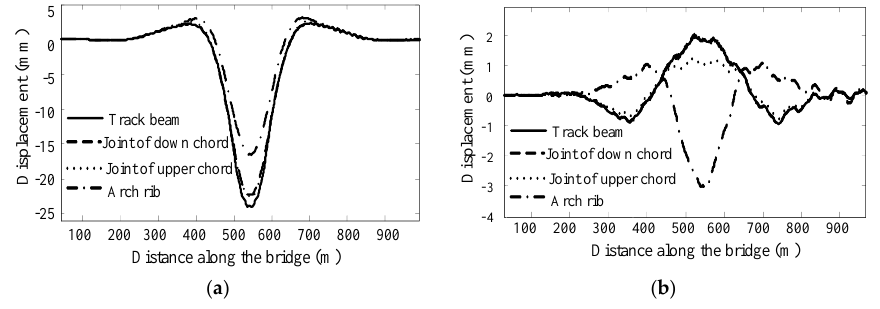
Figure 7a,b plot the simulation results of the time-displacement curves of the track beam, joint of the down chord, joint of the upper chord, and the arch rib in the vertical and transverse direction of the bridge, respectively, under one train running through the bridge at a speed of 60 km/h. The horizontal axis represents the distance along the bridge, which is measured from one end of the bridge. Both the vertical and transverse displacements reach their maximum values when the train arrives at a distance of 530 m on the bridge. Figure 7a shows that the vertical deflection of the track beam is the largest, followed by the deflection of the joint of the down and upper chords. Figure 7b shows that the transverse displacement of the arch rib is larger than that of the girder, which suggests that the transverse vibration of the arch rib is greater due to the smaller out-plane stiffness.